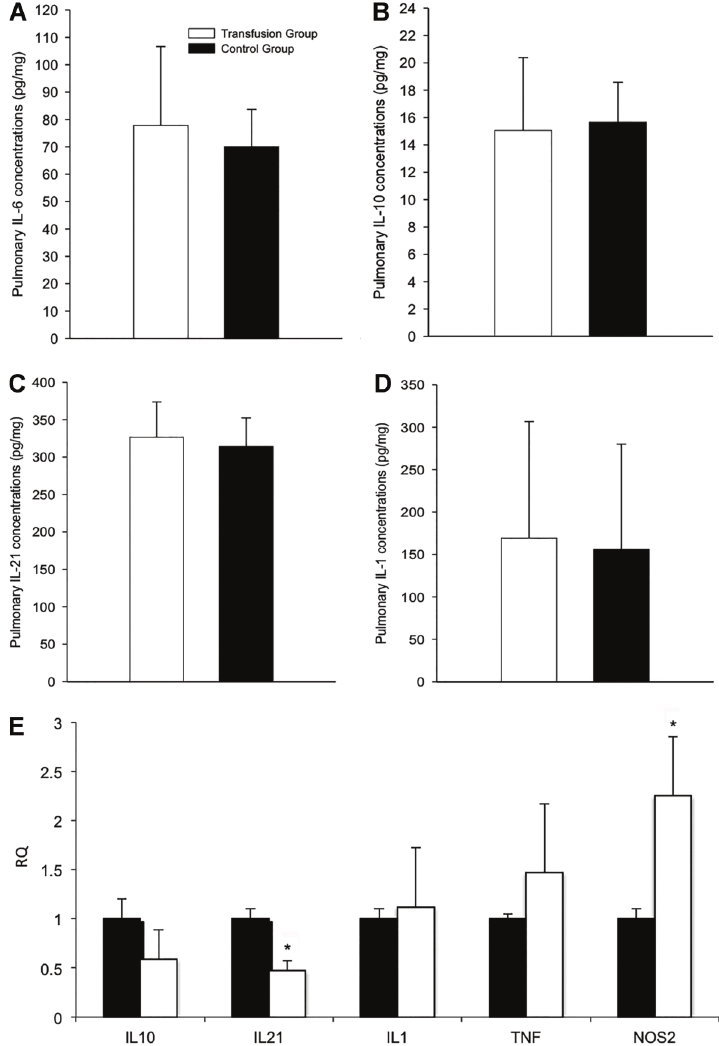
Figure 3. In fl ammatory parameters of the groups during the study. Panel A , pulmonary IL-6 con- centrations (P=0.401, t -test). Panel B , pulmo- nary IL-10 concentrations (P=0.817, t -test). Panel C , pulmonary IL-21 concentrations (P=0.567, t -test). Panel D , pulmonary IL-1 concentrations (P=0.844, t -test). Panel E , Relative mRNA quanti fi cation (RQ) for cytokines and NOS2 in lung tissue. Data are reported as means ± SD for 8 animals per group. Animals were sacri fi ced 6 h after the end of transfu- sion. *P o 0.05 vs Control ( t